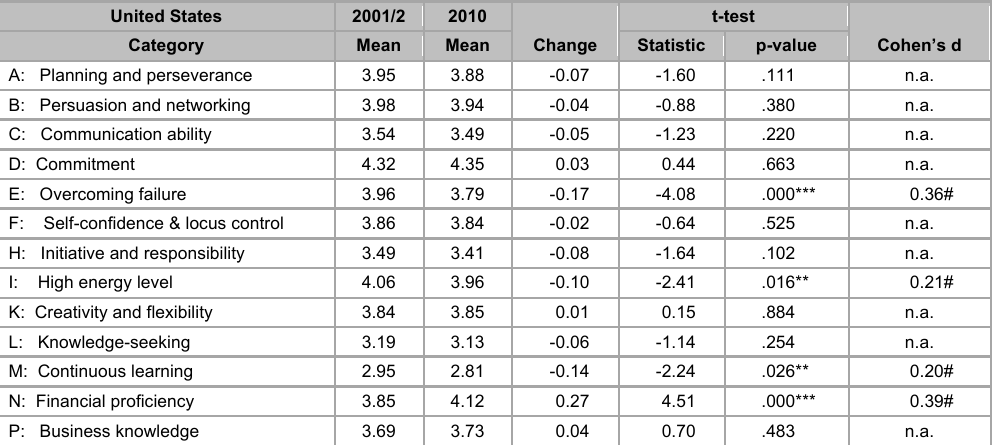
Significance of differences between time periods – USA sample United States 2001/2 2010